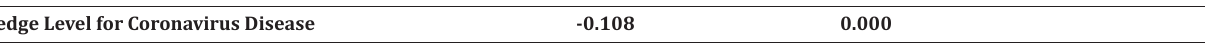
Knowledge Level for Coronavirus